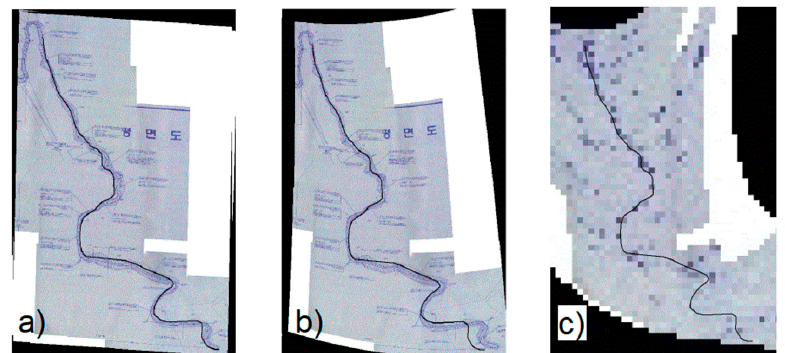
Figure 3. Examples of image warping using blueprints and GCP: ( a ) 1st transformation (linear), ( b ) 2nd transformation, ( c ) 3rd transformation. The image warping effect decreases when using the 2nd and 3rd transformations.